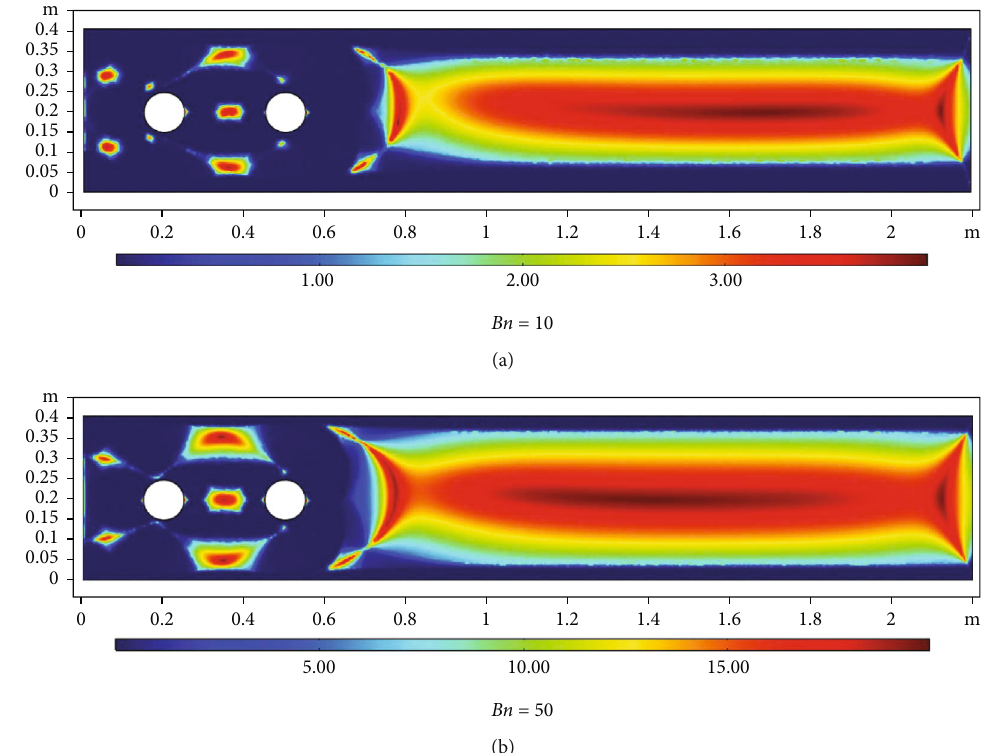
Figure 10: Viscosity pro fi les for various Bn with G